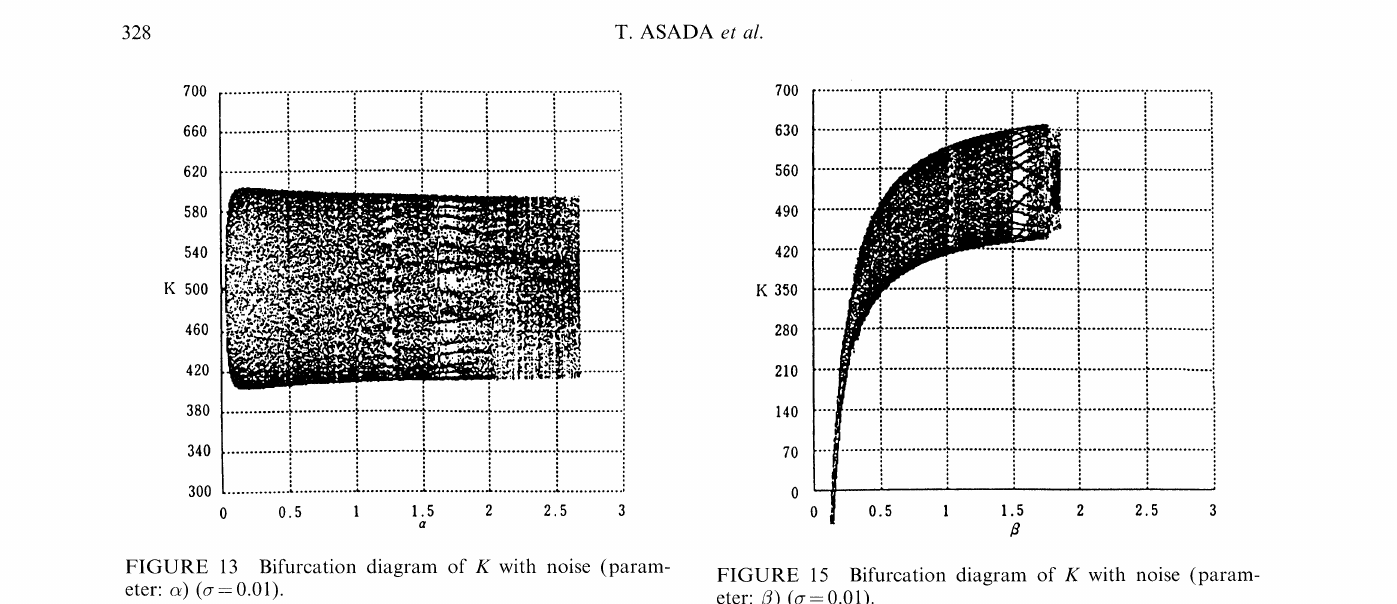
FIGURE 15 Bifurcation diagram of K with noise (param- eter: /3) (or 0.01).